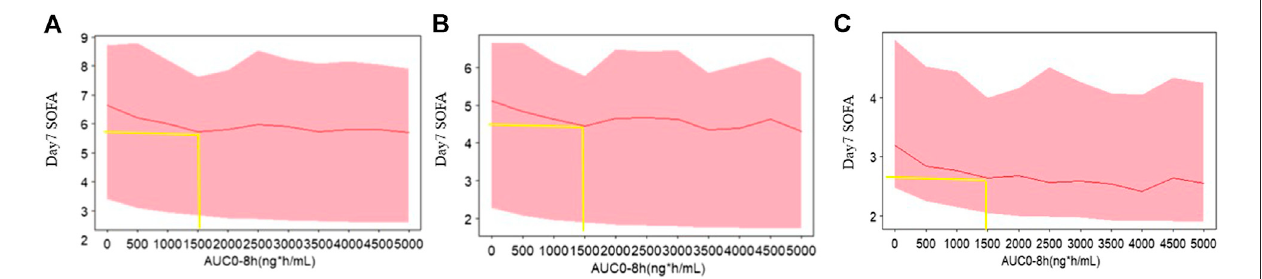
FIGURE3| Thesimulatedpro fi lesofday7SOFAvs.AUCbasedontheexposuremodel (A) baseline15, (B) baseline10,and (C) baseline5.Theredlinesrepresent the50thpercentilesofSOFAscoredistributionineach panel.Theupper andlowerbound ofshadowrepresentthe30thand70thpercentilesofSOFAscoredistribution in each